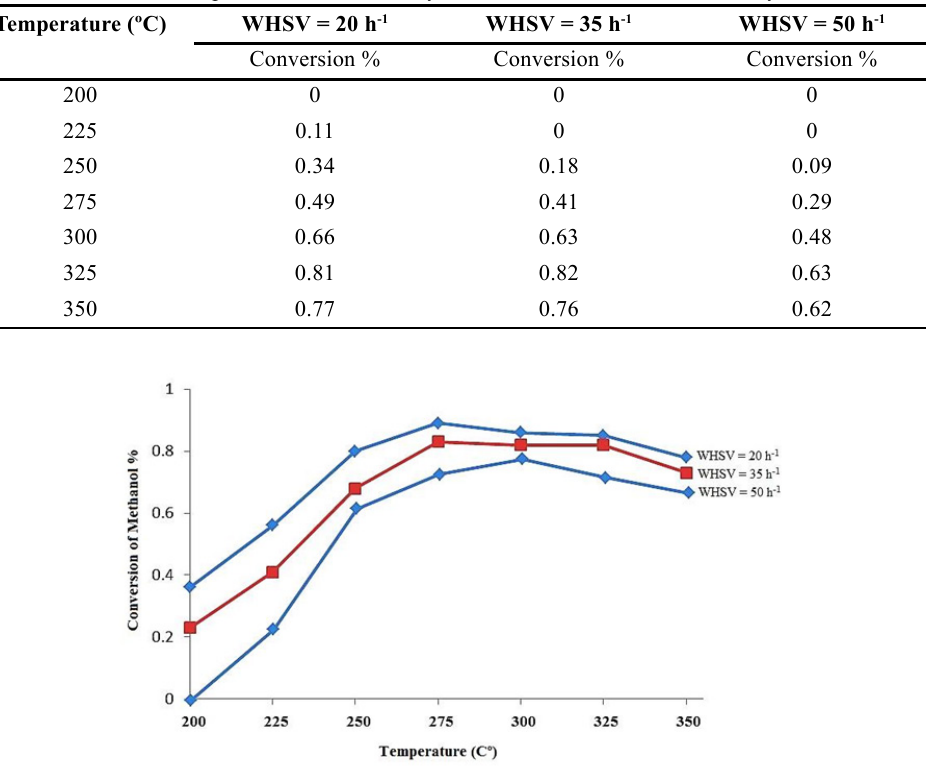
Fig. 8 . Conversion of methanol as a function of reaction temperature profile obtained over Al-B catalyst